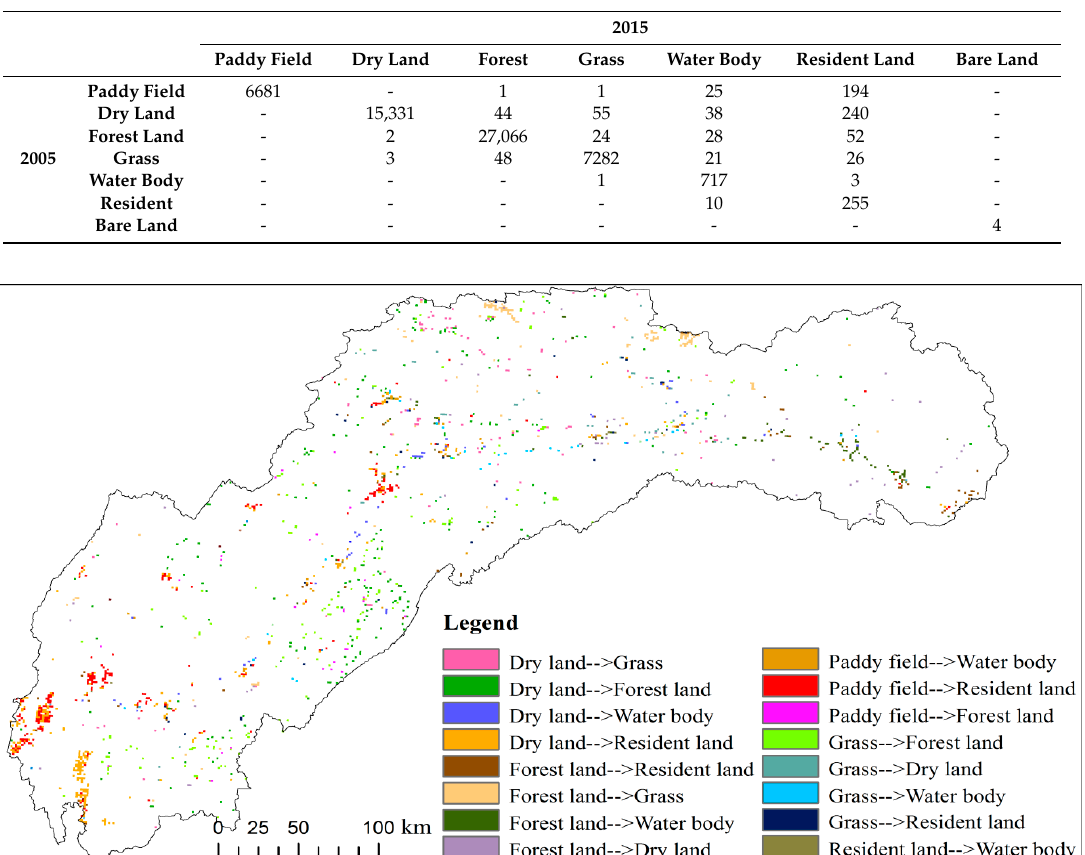
Table 4. Land use transition matrix in the study area from 2005 to 2015 (unit: km 2 ).